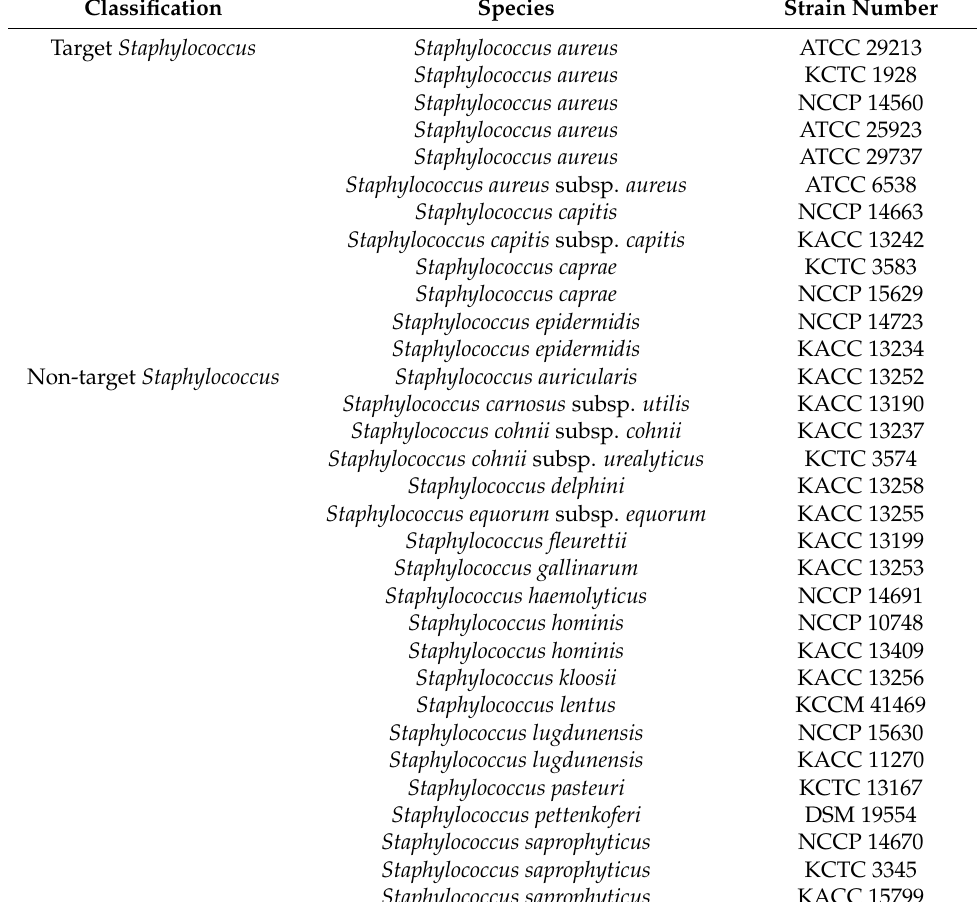
Table 1. List of reference strains used in this